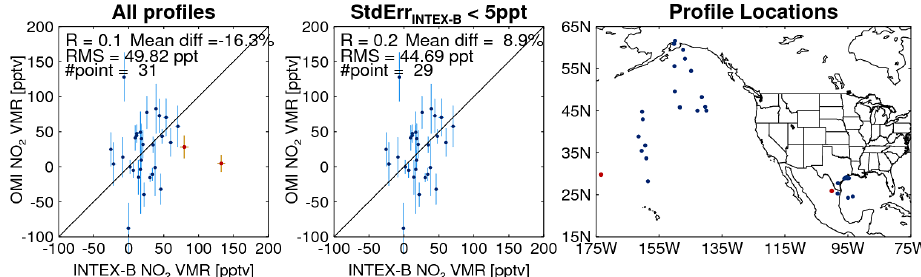
Figure 6. Scattergram of INTEX-B and OMI cloud-slicing NO 2 VMRs; left: all available collocations of INTEX-B and OMI NO 2 VMR; middle: collocations where the INTEX-B standard error of the mean < 5pptv; right: locations of the profiles. Red shows cases where the INTEX-B standard error of the mean >